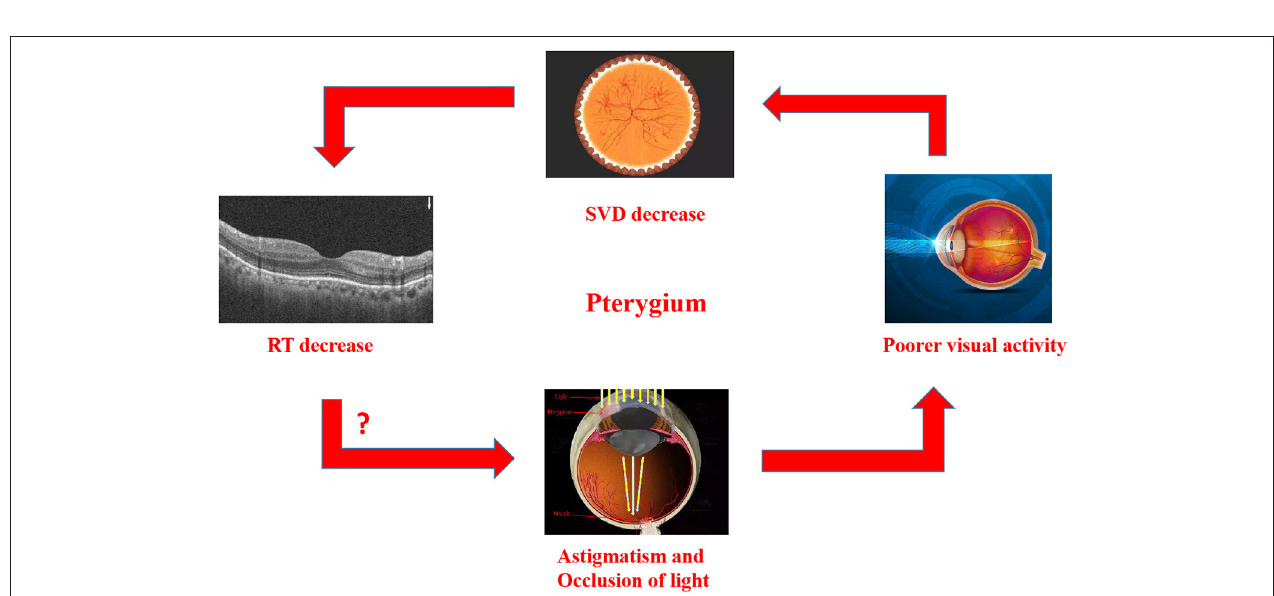
FIGURE 5 | The correlation between RT and pterygium length and area in patients with pterygium. (A) RT in ON area of internal retina was in a negative correlation with the length of pterygium (r = − 0.5803, P = 0.0376). (B) RT in ON region of the complete retina was in a negative correlation with area of pterygium (r = − 0.6013, P = 0.0297). (C) Total retinal RT is negatively correlated with pterygium area (r = − 0.5844, P = 0.0359). RT, retinal thickness; IN, inner nasal; ON, outer nasal.